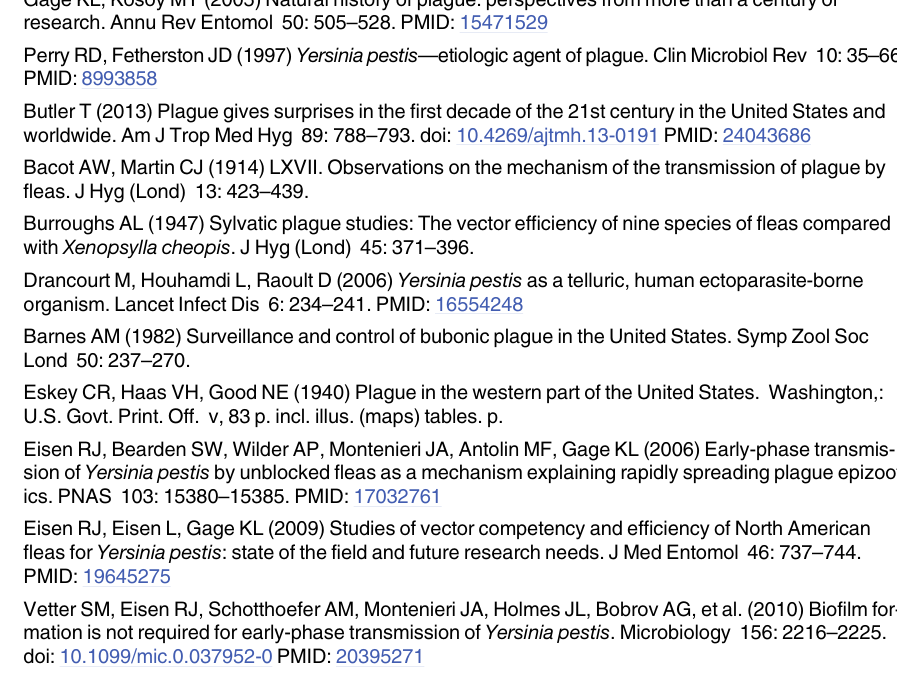
O . After 20 min- 2 2